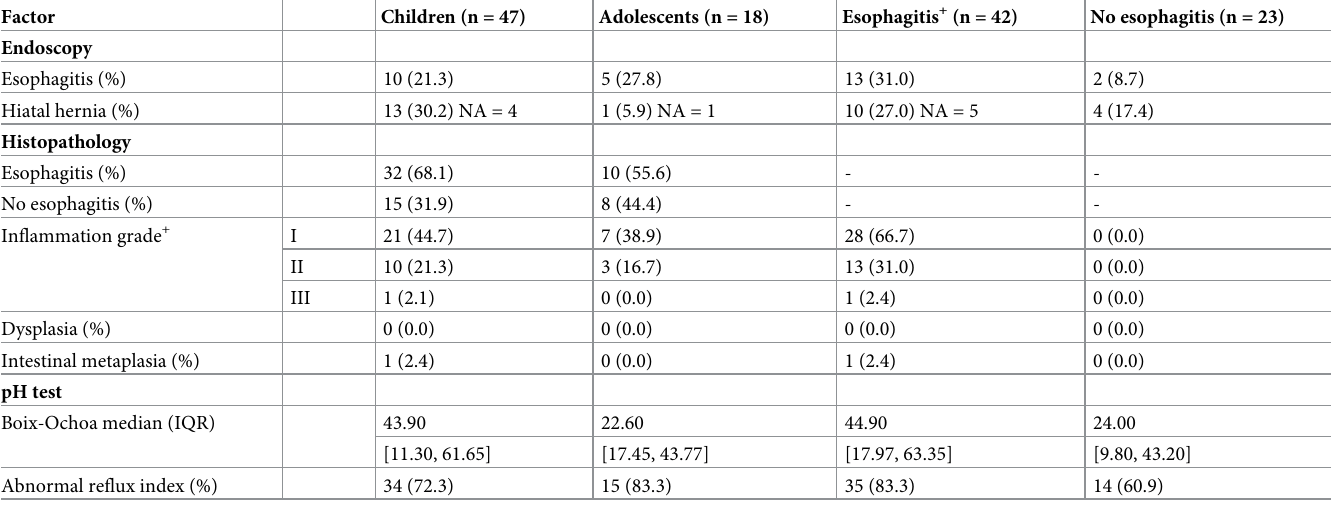
Table 2. Follow-up results by group.